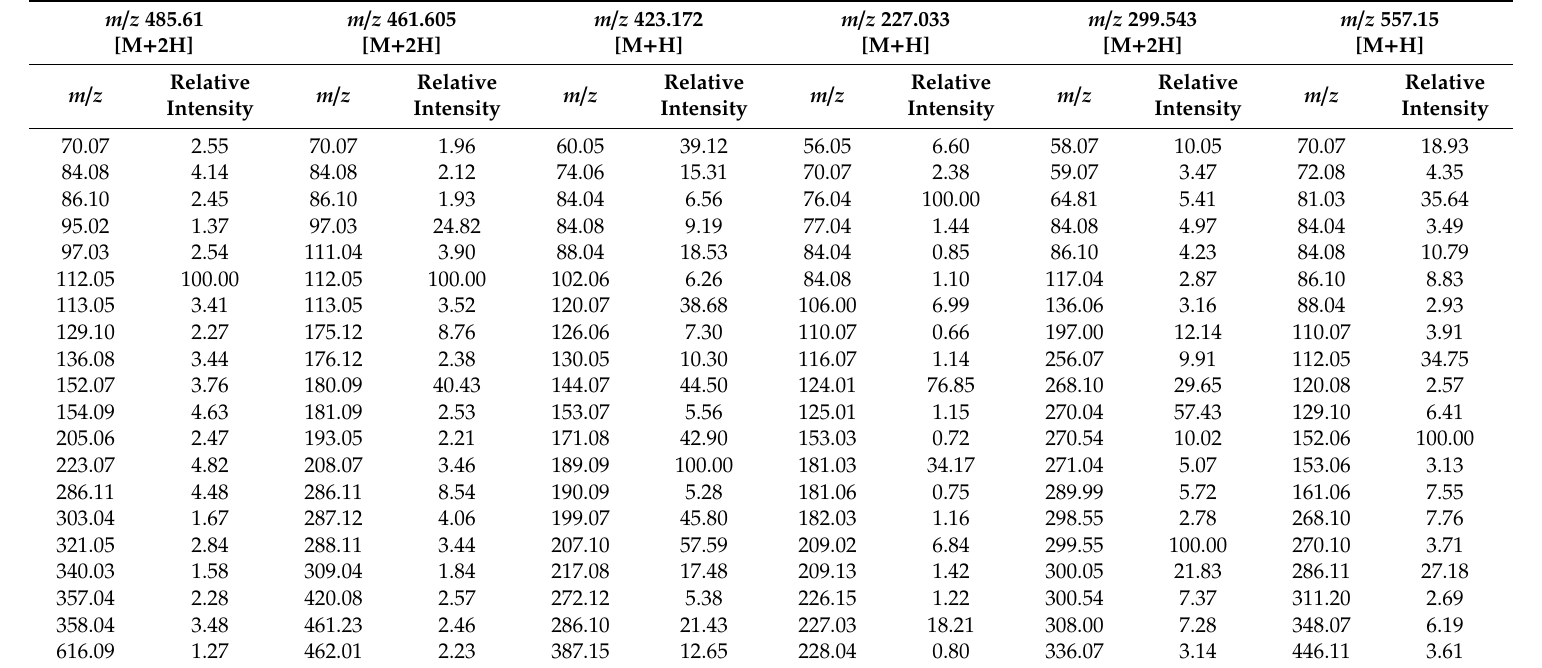
Table A6. The MS2 peak lists of the uncharacterized metabolites detected specifically in A. oligospora